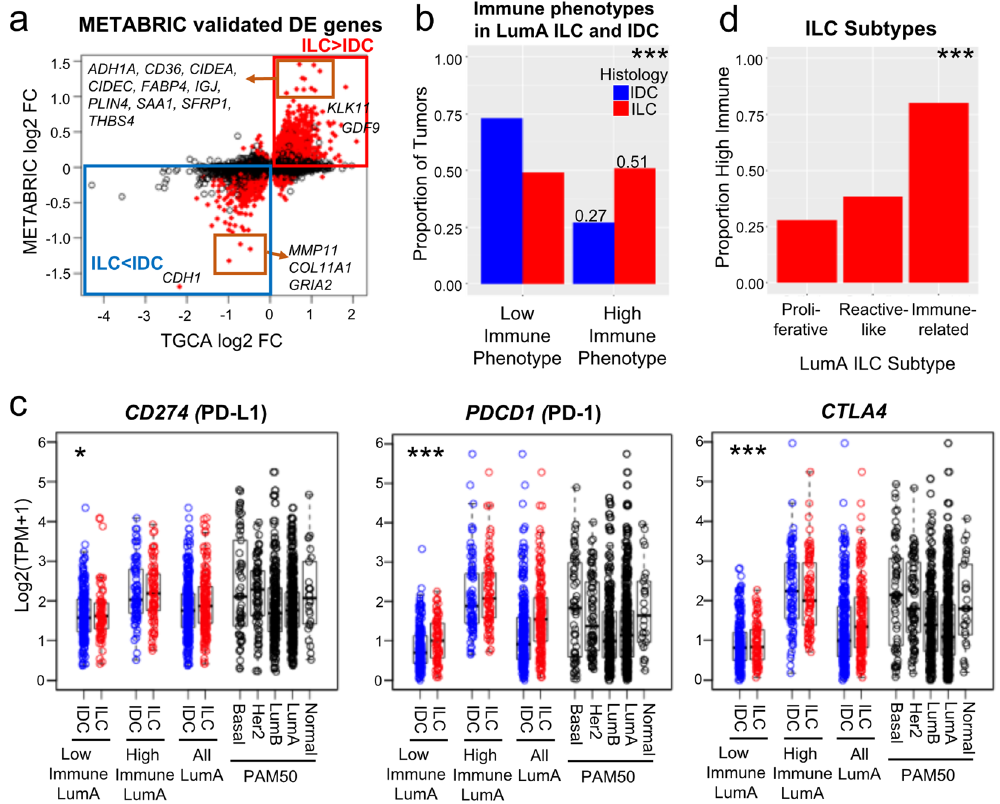
Figure 1. LumA ILC is enriched for immune cell infiltration and high immune-checkpoint gene expression. ( a ) 853 up-regulated genes and 602 down-regulated genes (LumA ILC, n = 159 vs LumA IDC, n = 311, FDR < 0.05) in TCGA were validated in METABRIC (marked in red, the direction of the changes for DE genes were matched). ( b ) Proportion of immune phenotypes in LumA ILC (n = 157) and LumA IDC (n = 303). Tumors were classified into 6 immune-phenotypes (immune-phenotype 1–6) by Tamborero et al . and those in immune-phenotype 1–3 and 4–6 were defined as low immune tumors and high immune tumors, respectively. Chi-square test, *** p < 0.0005. ( c ) Expression of CD274 (PD-L1), PDCD1 (PD-1) and CTLA4 in LumA ILC and LumA IDC of different immune phenotypes. High Immune LumA ILC and IDC have similar PDCD1, and CTLA4 expression as Basal and HER2 subtypes. Low immune (LumA ILC, n = 77, vs LumA IDC n = 221), high immune (LumA ILC, n = 80, vs LumA IDC n = 82), all (LumA ILC, n = 157 vs LumA IDC, n = 303). Two-way ANOVA for the effect of histological subtype on immune checkpoint gene expression, * p < 0.05, ** p < 0.005, *** p < 0.0005. The effect of immune phenotype on immune checkpoint gene expression, p < 0.0005 for all genes. No significant interaction (p > 0.05) between histology and immune phenotype. ( d ) Proportion of high immune tumors in ILC subtypes (Proliferative n = 18, Reactive-like n = 34, Immune-related n = 40). Chi-square test for equality of proportions, *** p <